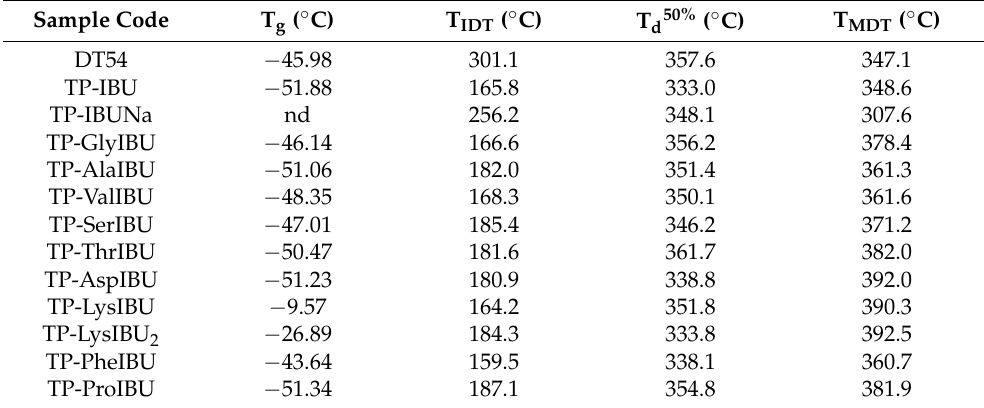
Table 4. Glass transitions and the thermal stability of acrylic PSAs and PSAs with ibuprofen (IBU) and its structural